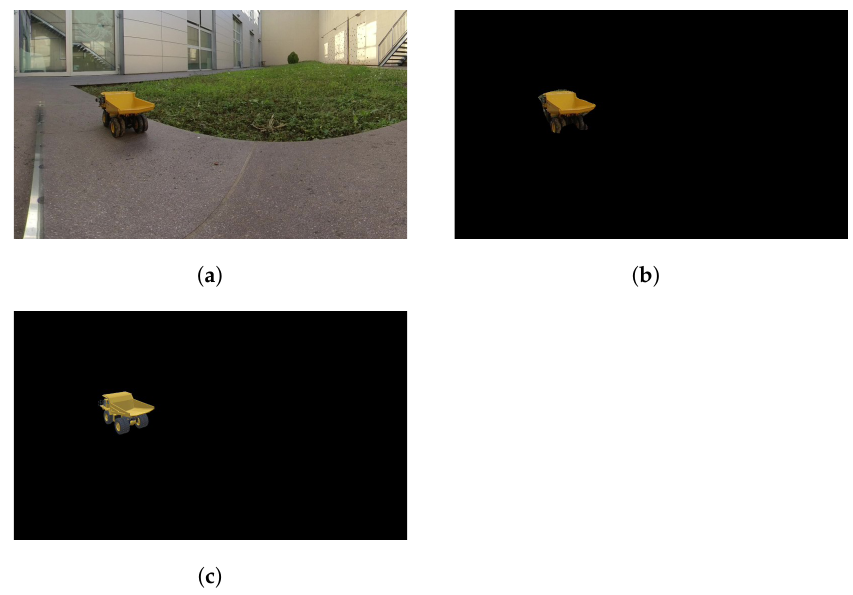
Figure 14. Optimization result where the camera was translated by 72cm. ( a ) Input equirectangular image taken by the 360° camera. ( b ) Result of the segmentation. ( c ) Optimization result in which the CAD is rendered in the final pose found by the optimization